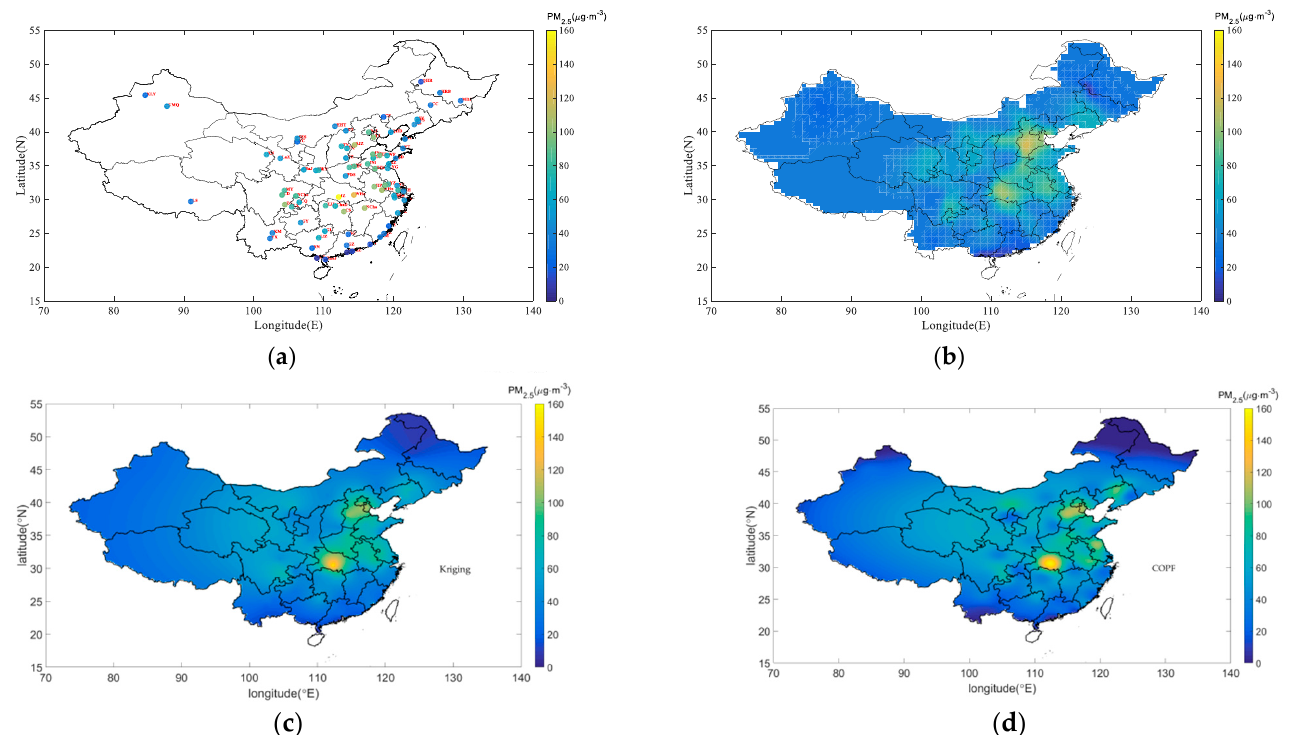
Figure 9. Mean observations of the 80 sample cities ( a ) and mean distribution of the simulated PM 2.5 on 17–20 May 2014 ( b – d ) .